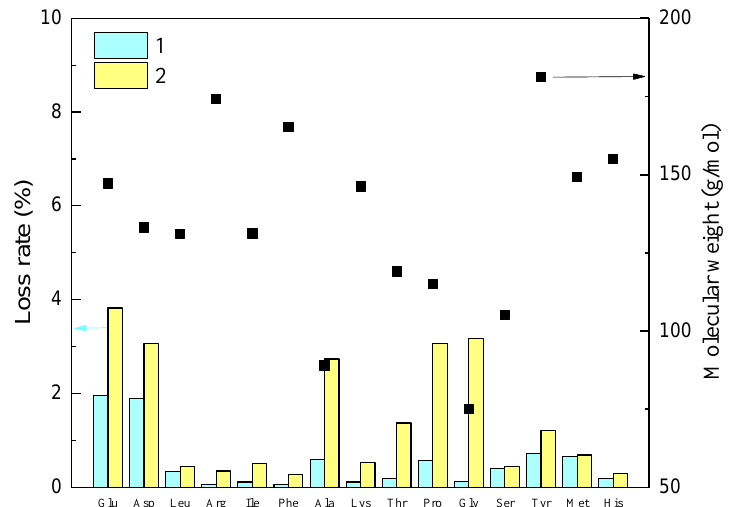
Figure 8. Loss rate of amino acids (black square) in the flask: 1 represents the data without membrane, 2 represents the data with membrane.